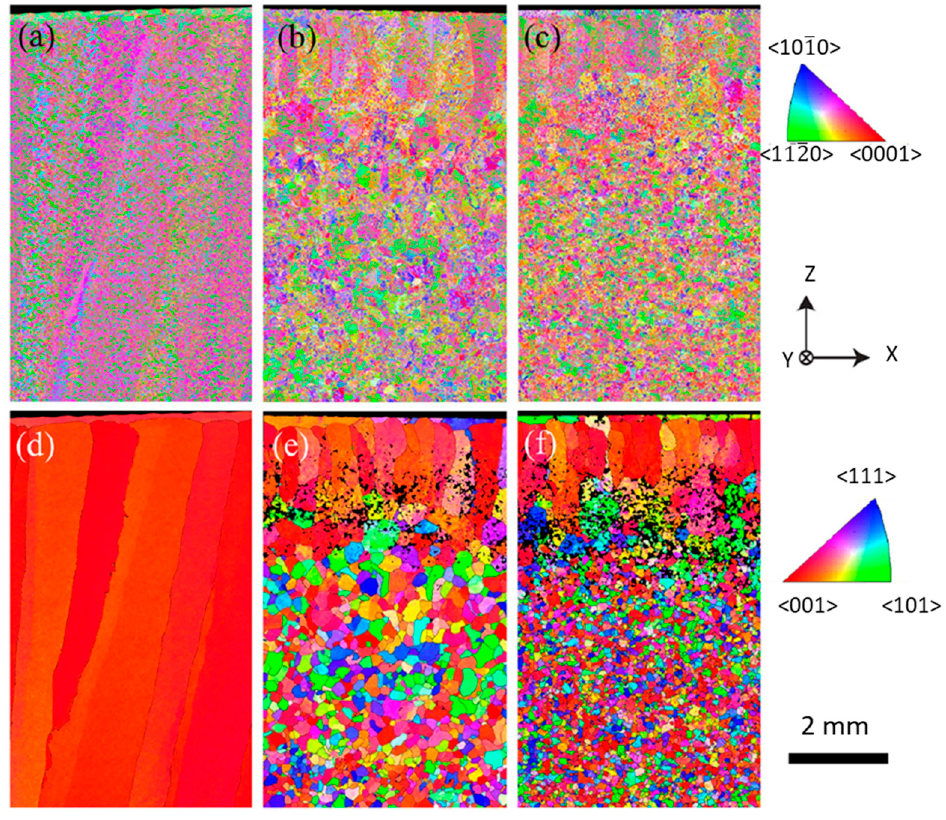
Figure 10. Electron backscatter diffraction (EBSD) maps of the α -phase ( a – c ) and reconstructed β -parent phase ( d – f ) of samples produced without rolling and with rolling loads of 50 kN and 75 kN (adapted from [51]).